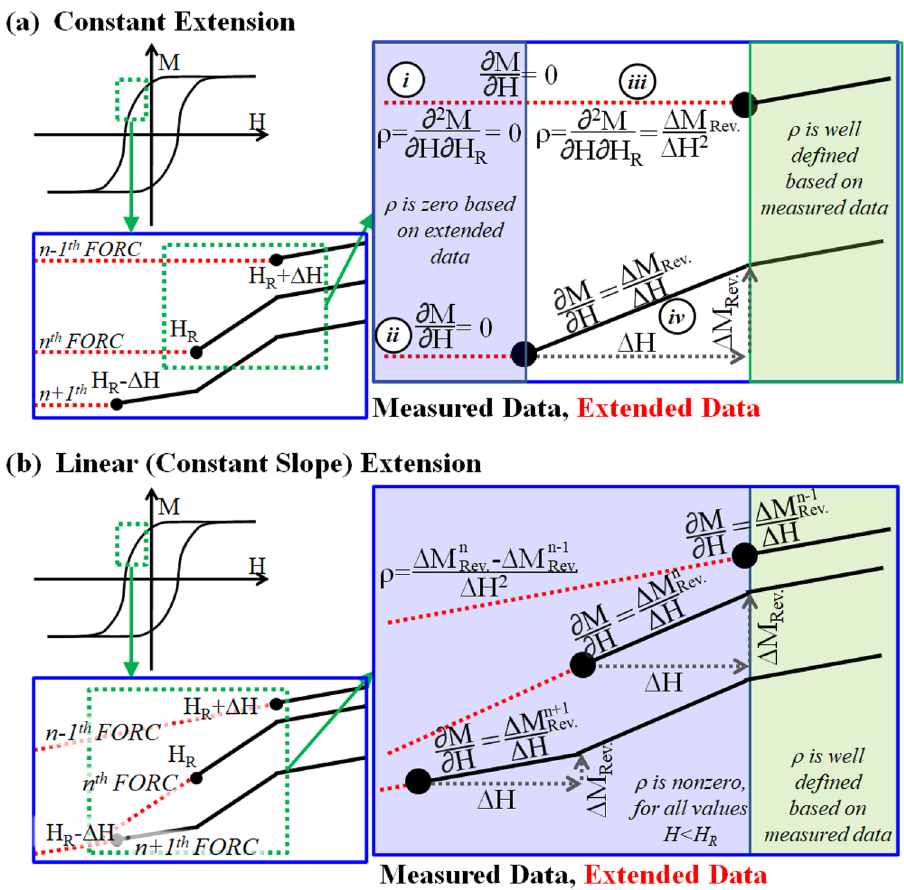
Figure 2. Schematic diagram of ( a ) constant and ( b ) constant slope extensions applied to the family of